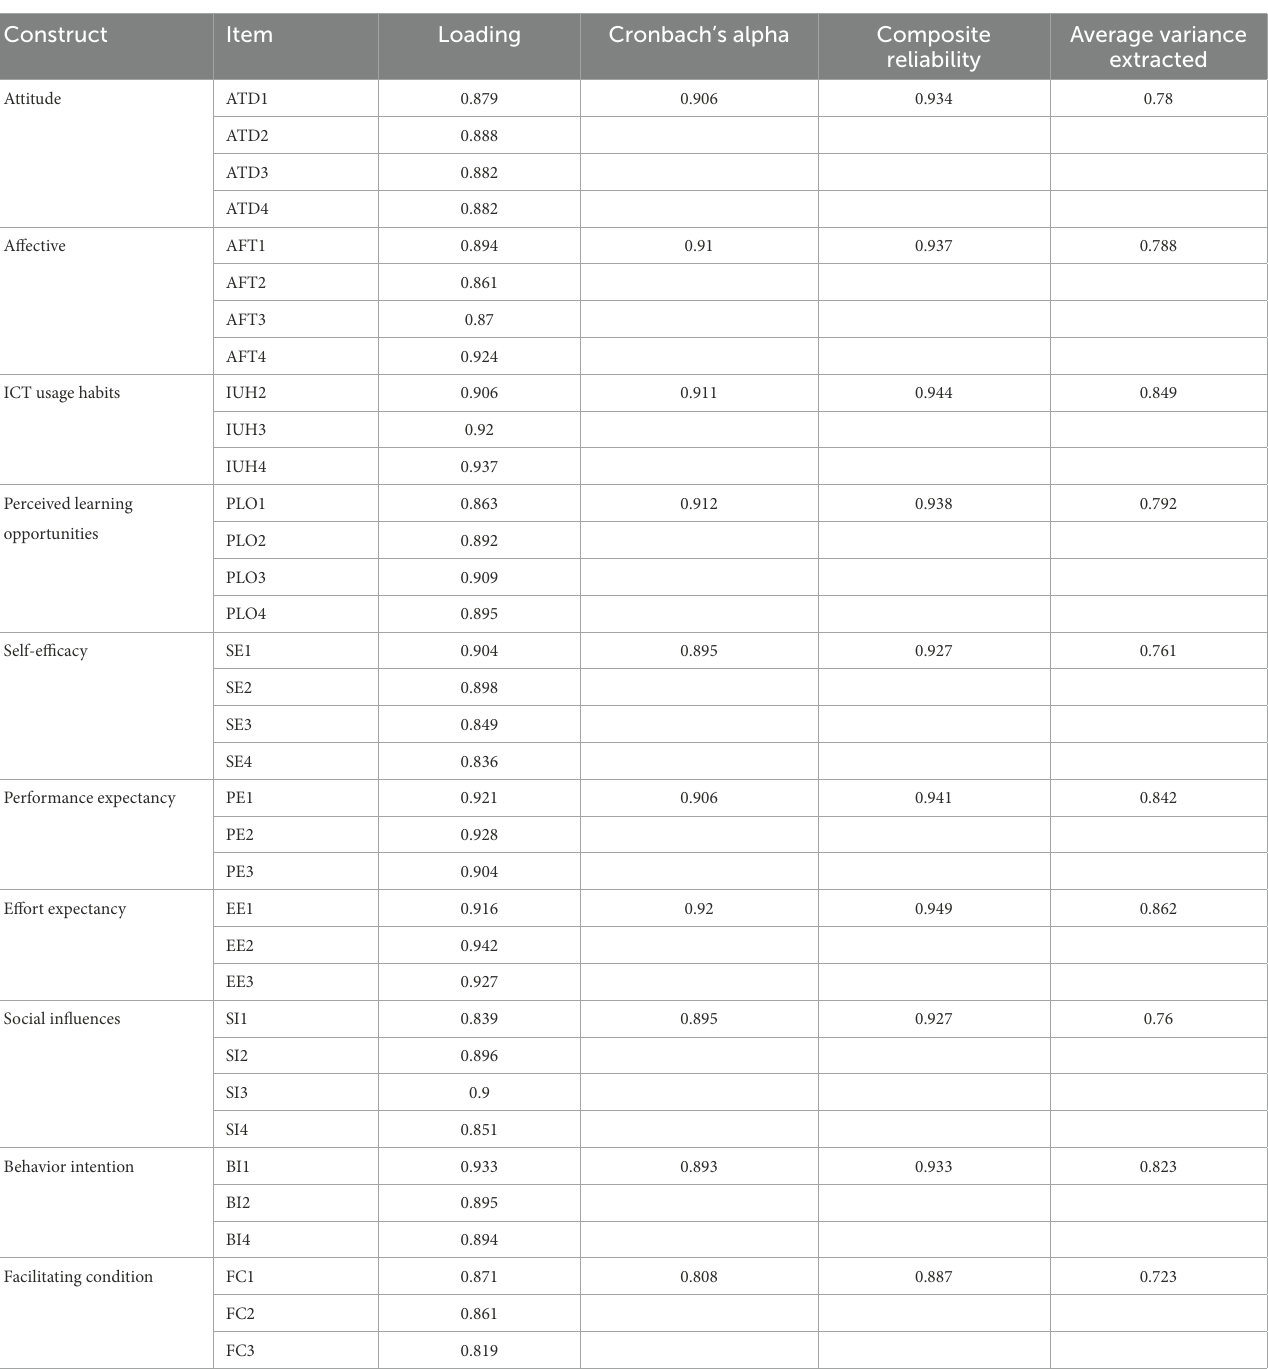
TABLE 3 Results of loading factor, validity, and